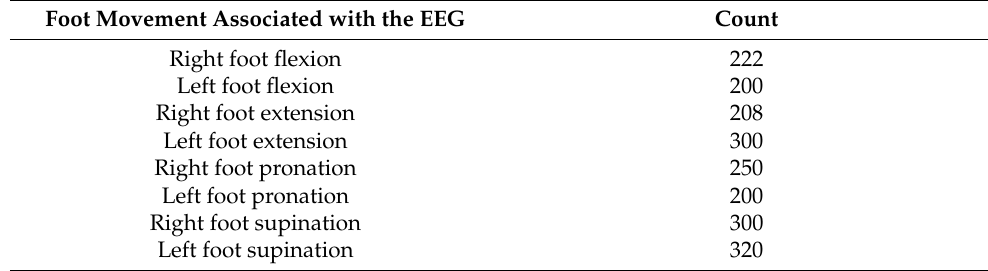
Table 2. Dataset statistics (total samples of EEG signals: 2000 from 271 cases).